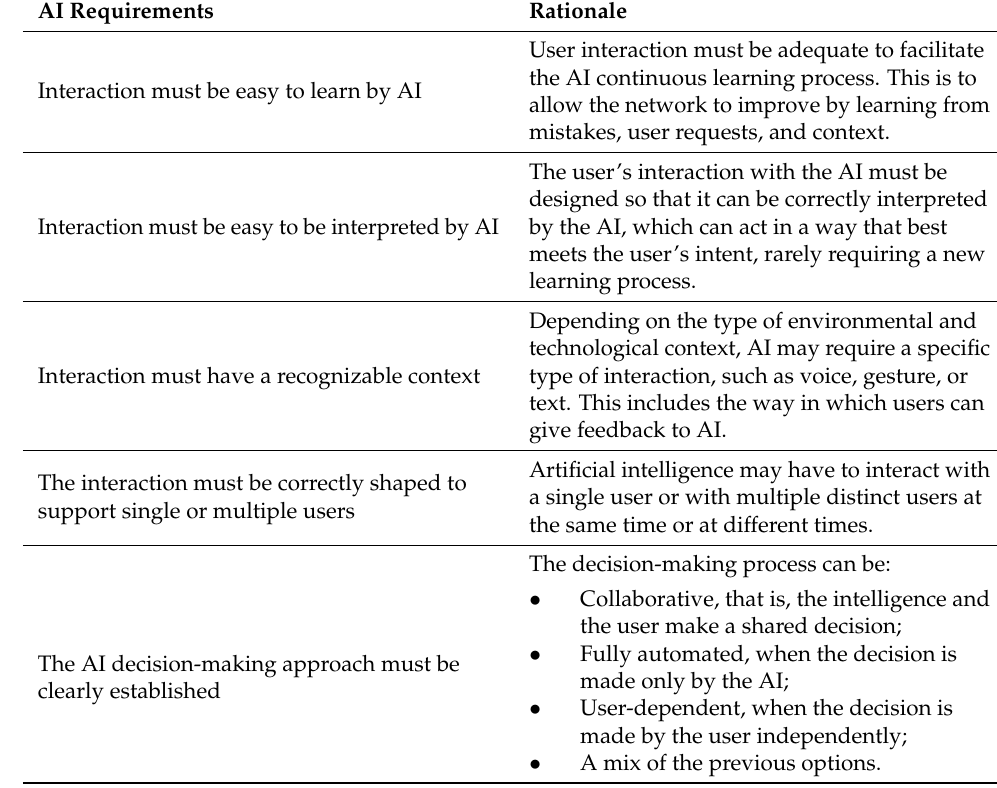
Table 1. Some possible AI requirements and their rationales based on our research and analysis.